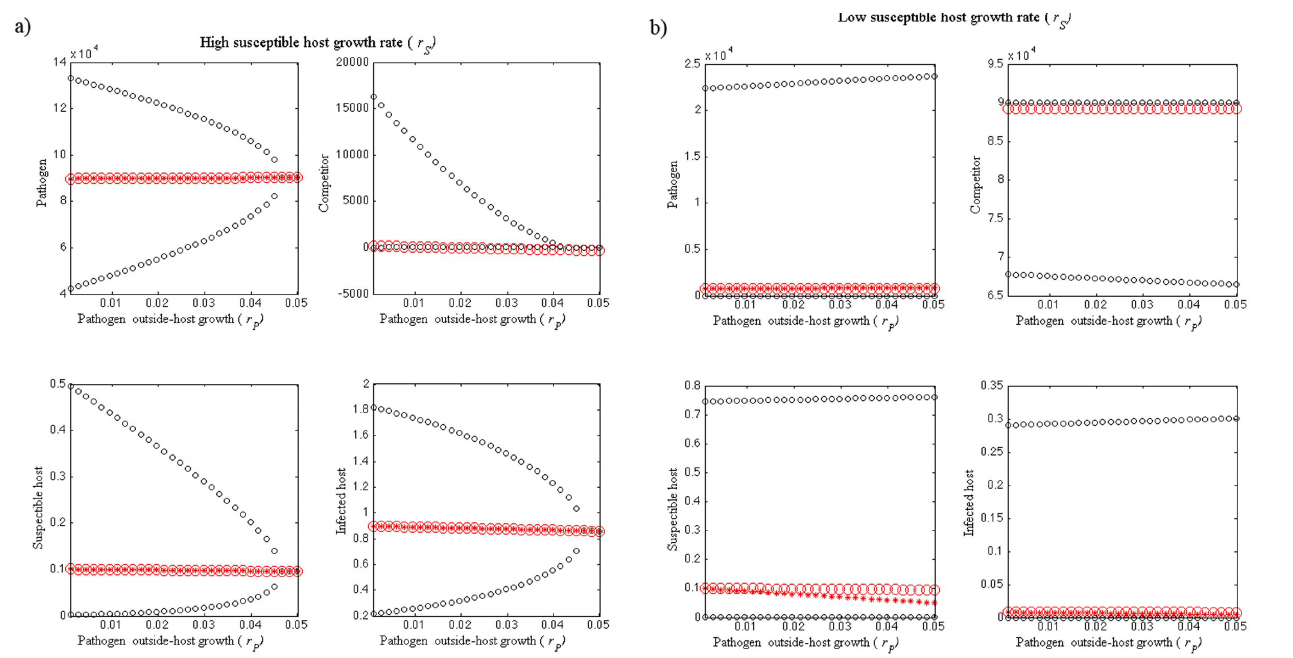
Figure 1. Bifurcation figures of the S-I-P-B dynamics, presenting maximum and minimum values (black circles), as well as equilibrium densities (red stars for when competitor ( B ) is not present, red circles when all the populations are present) of susceptible host ( S ), pathogen ( P ) and non- pathogenic ( B ) population densities in different combinations of outside-host growth rate of pathogen ( r P ) parameter values ( r P 5 0.001–0.5). a) When susceptible host growth rate ( r S ) is high ( r S 5 1), increasing r P stabilizes the disease dynamics. b) Disease dynamics are cyclic when susceptible host growth rate ( r S ) is low ( r S 5 0.01). Used parameter values are shown in Table 2.